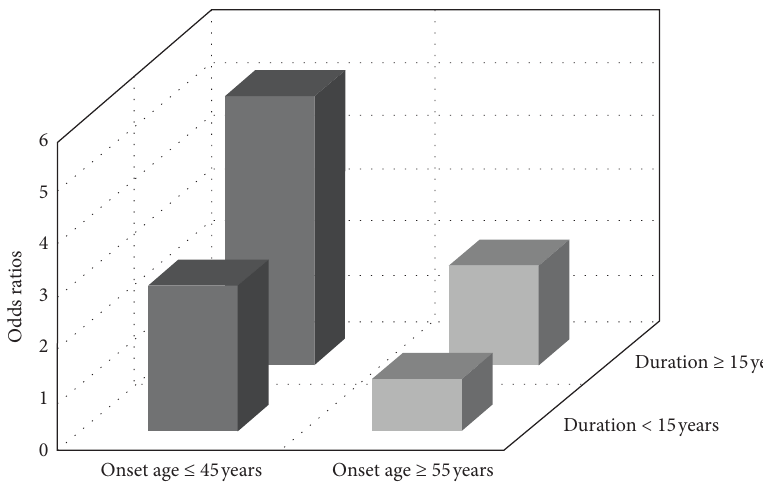
Figure 2: Odds ratios of DR by onset age of T2D and category of diabetic duration. Table 3: The risk of DR and PDR according to onset age of T2D.